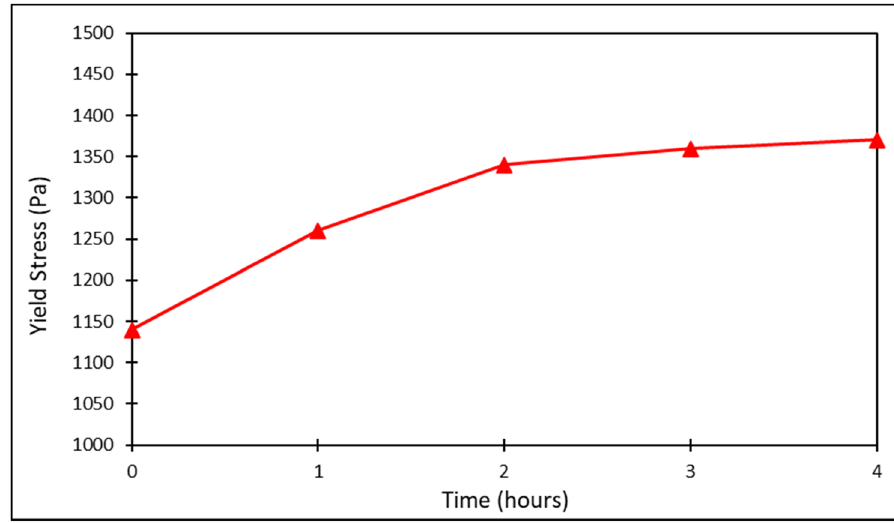
Figure 8: Yield stress for a copper tailing - based geopolymer paste at di ff erent times after